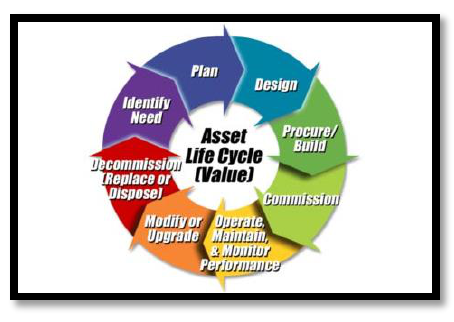
Figure 1 : The Asset Life Cycle Management